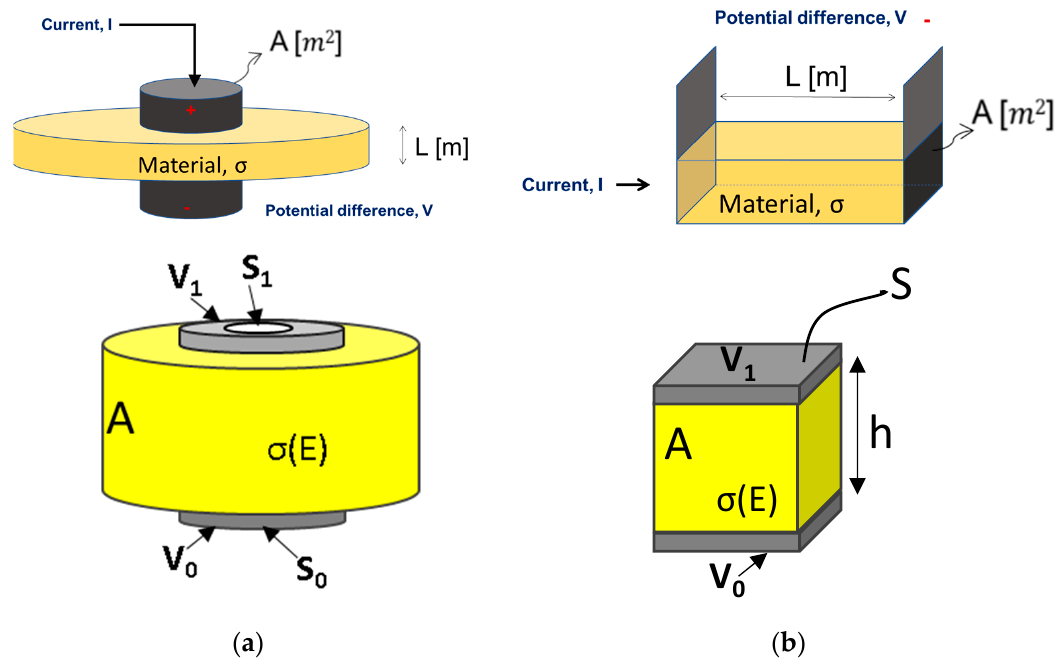
Figure 4. Schematic of the measurement set-ups and correspondent FEM models for ( a ) disk-shape model and ( b ) cube-shape model, with electrodes.